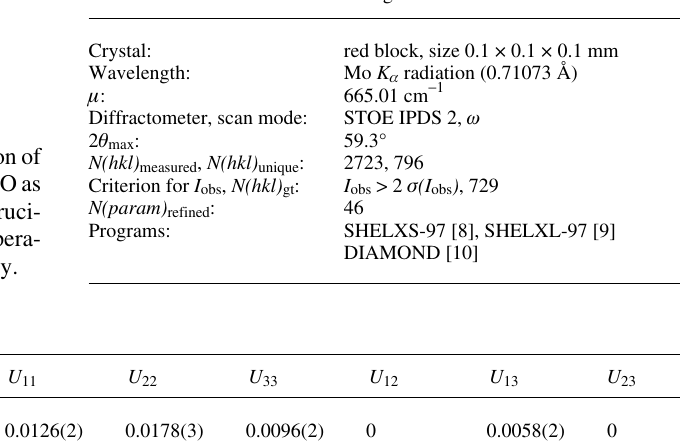
Table 1. Data collection and handling.